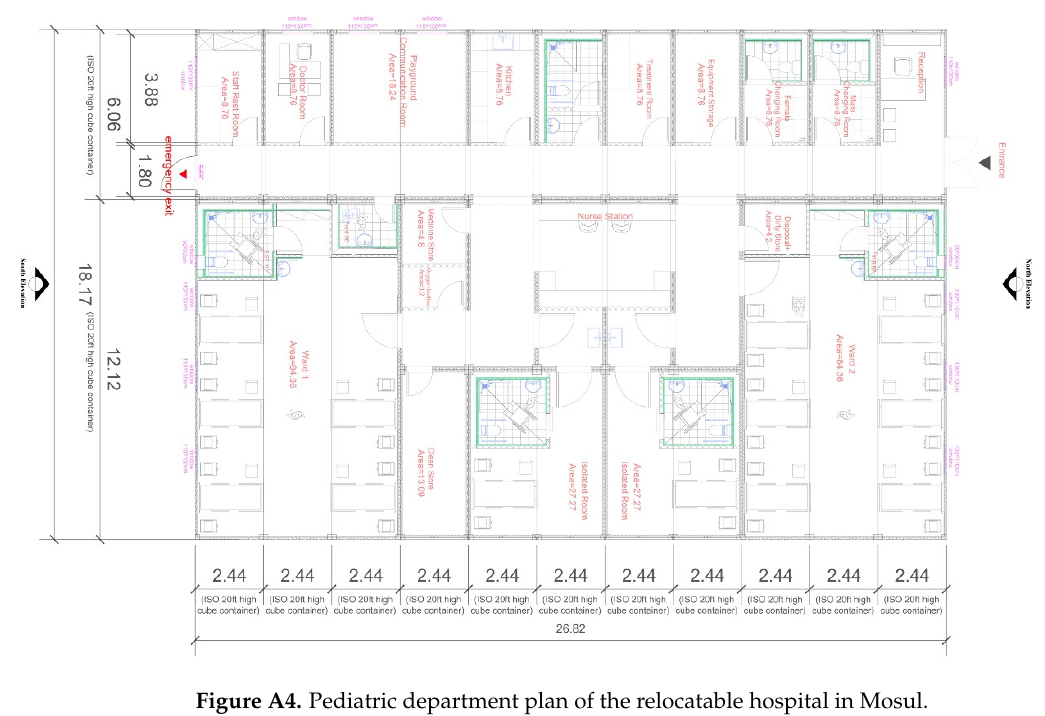
Figure A3. Dialysis department plan of the relocatable hospital in Mosul.